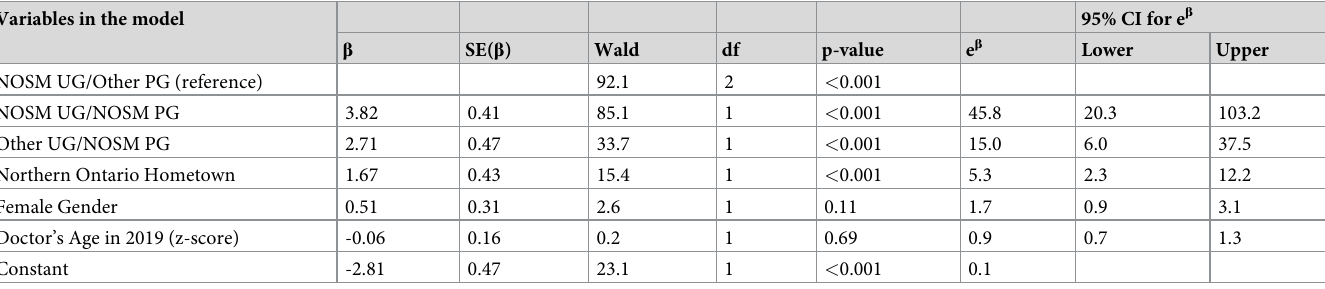
Table 3. Logistic regression model to predict northern Ontario practice location of 334 family doctors � . Variables in the